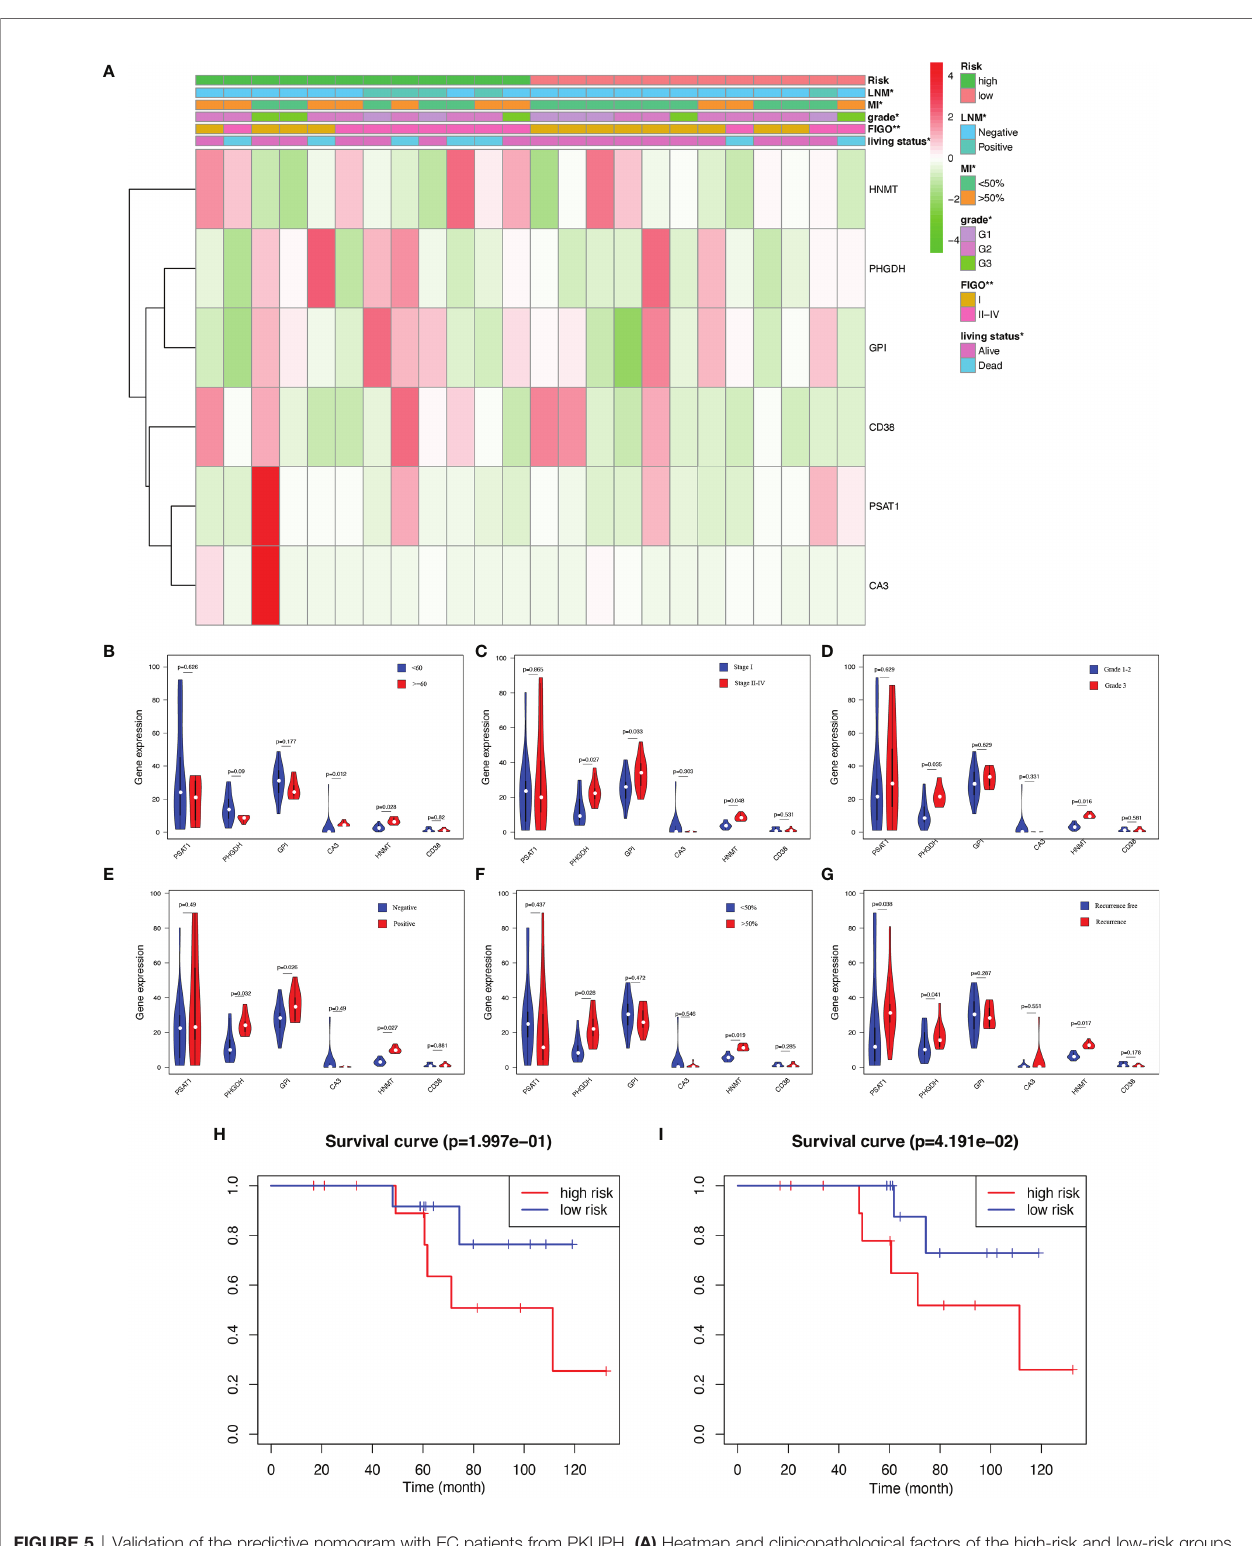
FIGURE 5 | Validation of the predictive nomogram with EC patients from PKUPH. (A) Heatmap and clinicopathological factors of the high-risk and low-risk groups based on the set of six metabolic genes. P-value is represented by * (P < 0.05) and ** (P < 0.01). Violin plot for the expression of six metabolism-related genes in the subgroups de fi ned by different clinicopathological risk factors including (B) age, (C) stage, (D) grade, (E) LNM, (F) myometrial invasion, and (G) recurrence. Survival curves of the high-risk and low-risk groups based on (H) the metabolism-related risk signature including six genes and (I) the